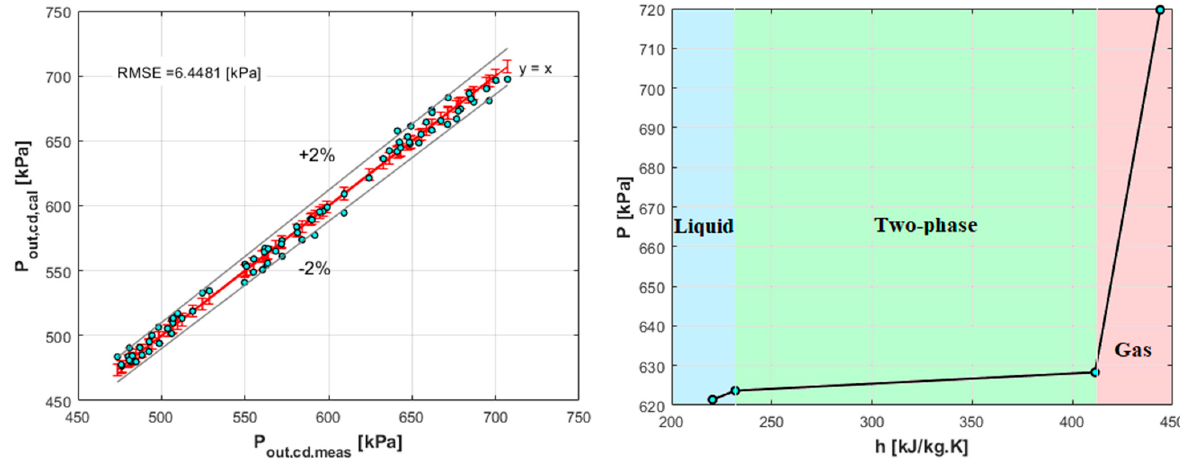
Figure 16. Calculated and measured pressure drop of the condenser ( left ) and pressure drop resolution in different heat transfer zones in the condenser ( right ).